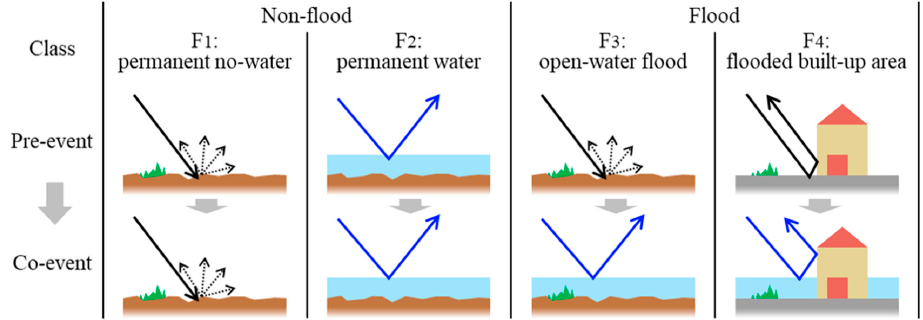
Figure 4. Schematic illustration of the four categories of flood / non-flood states adopted in this study. Table 3. ( a ) Parameters of the probability density function; ( b ) values of the parameters for each beam of the ALOS-2 3-m mode